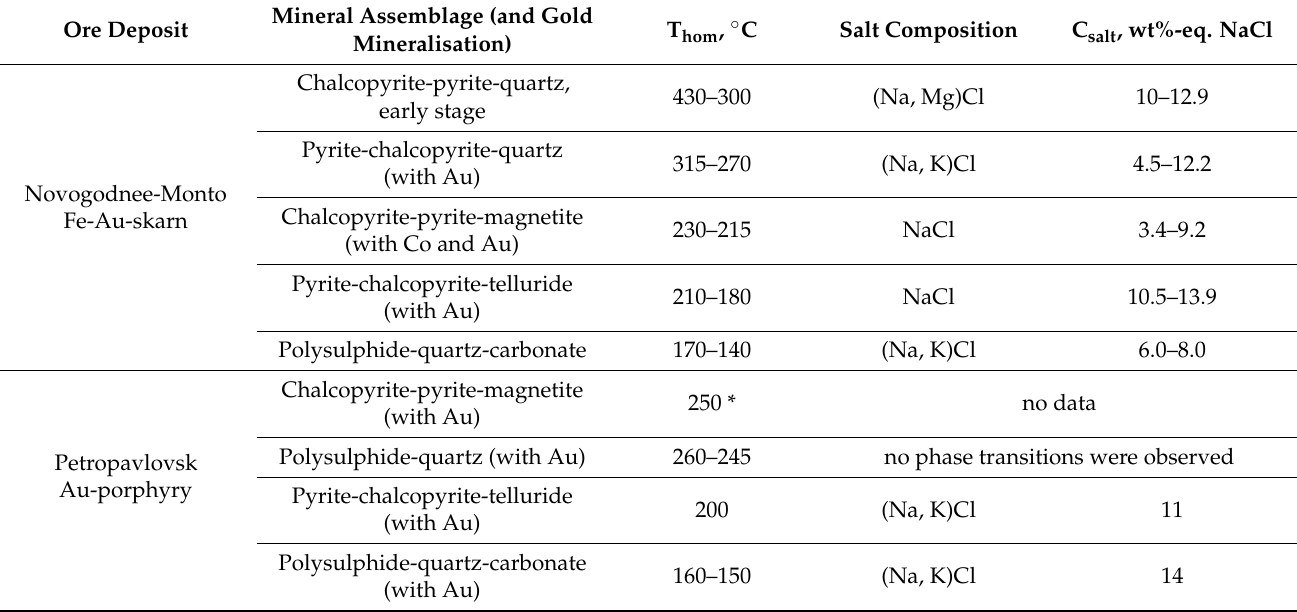
Table 4. Mineral assemblages and physicochemical parameters of mineral-forming fluids of the Petropavlovsk gold field. Ore